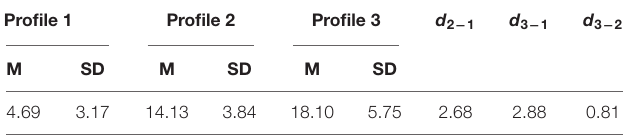
TABLE 4 | Means, standard deviations, and Cohen’s d for the three profiles of CES-D-10.